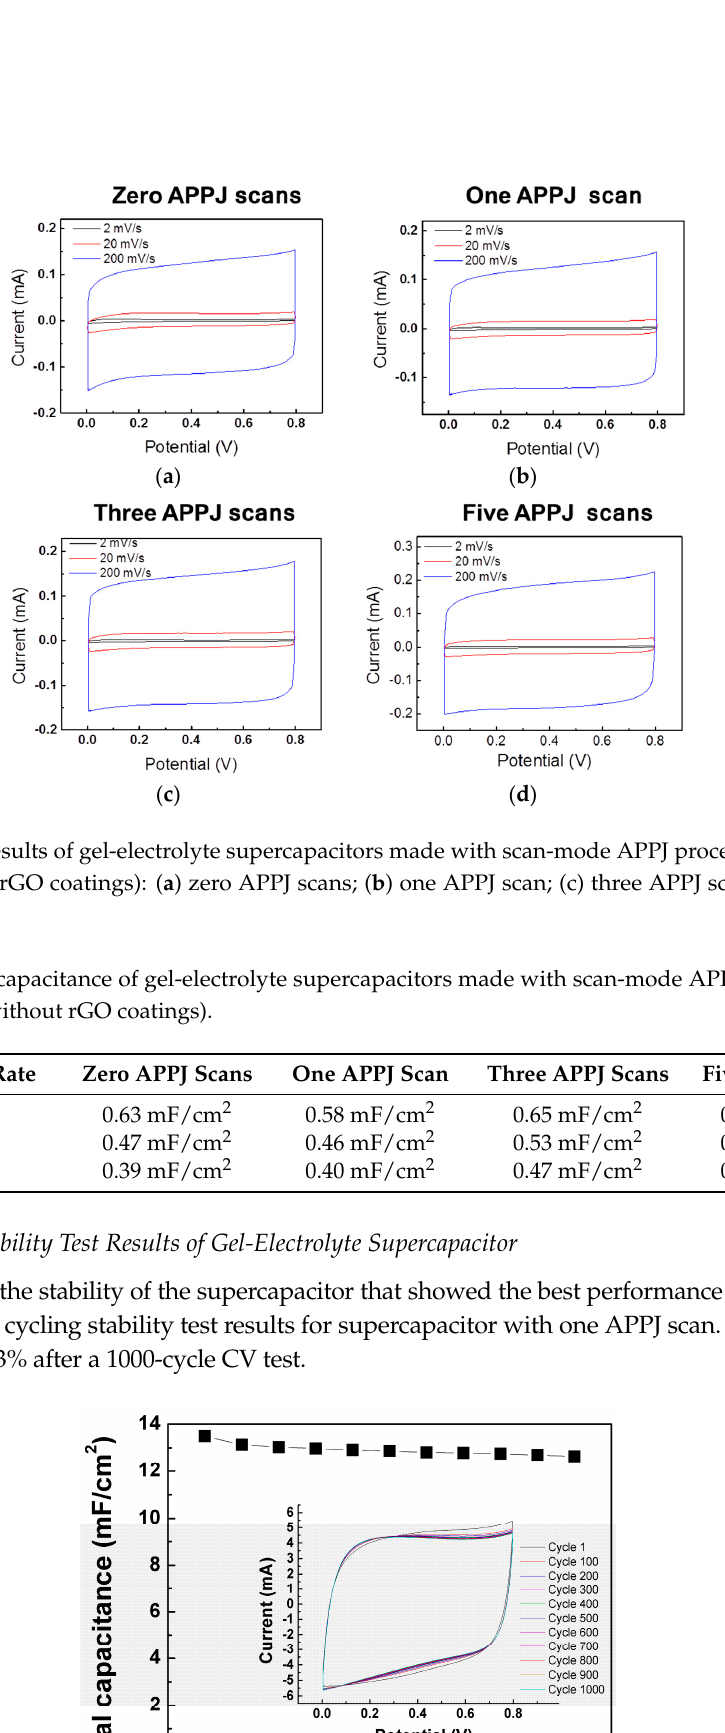
Figure 9. CV stability result of gel-electrolyte supercapacitor with one APPJ scan.